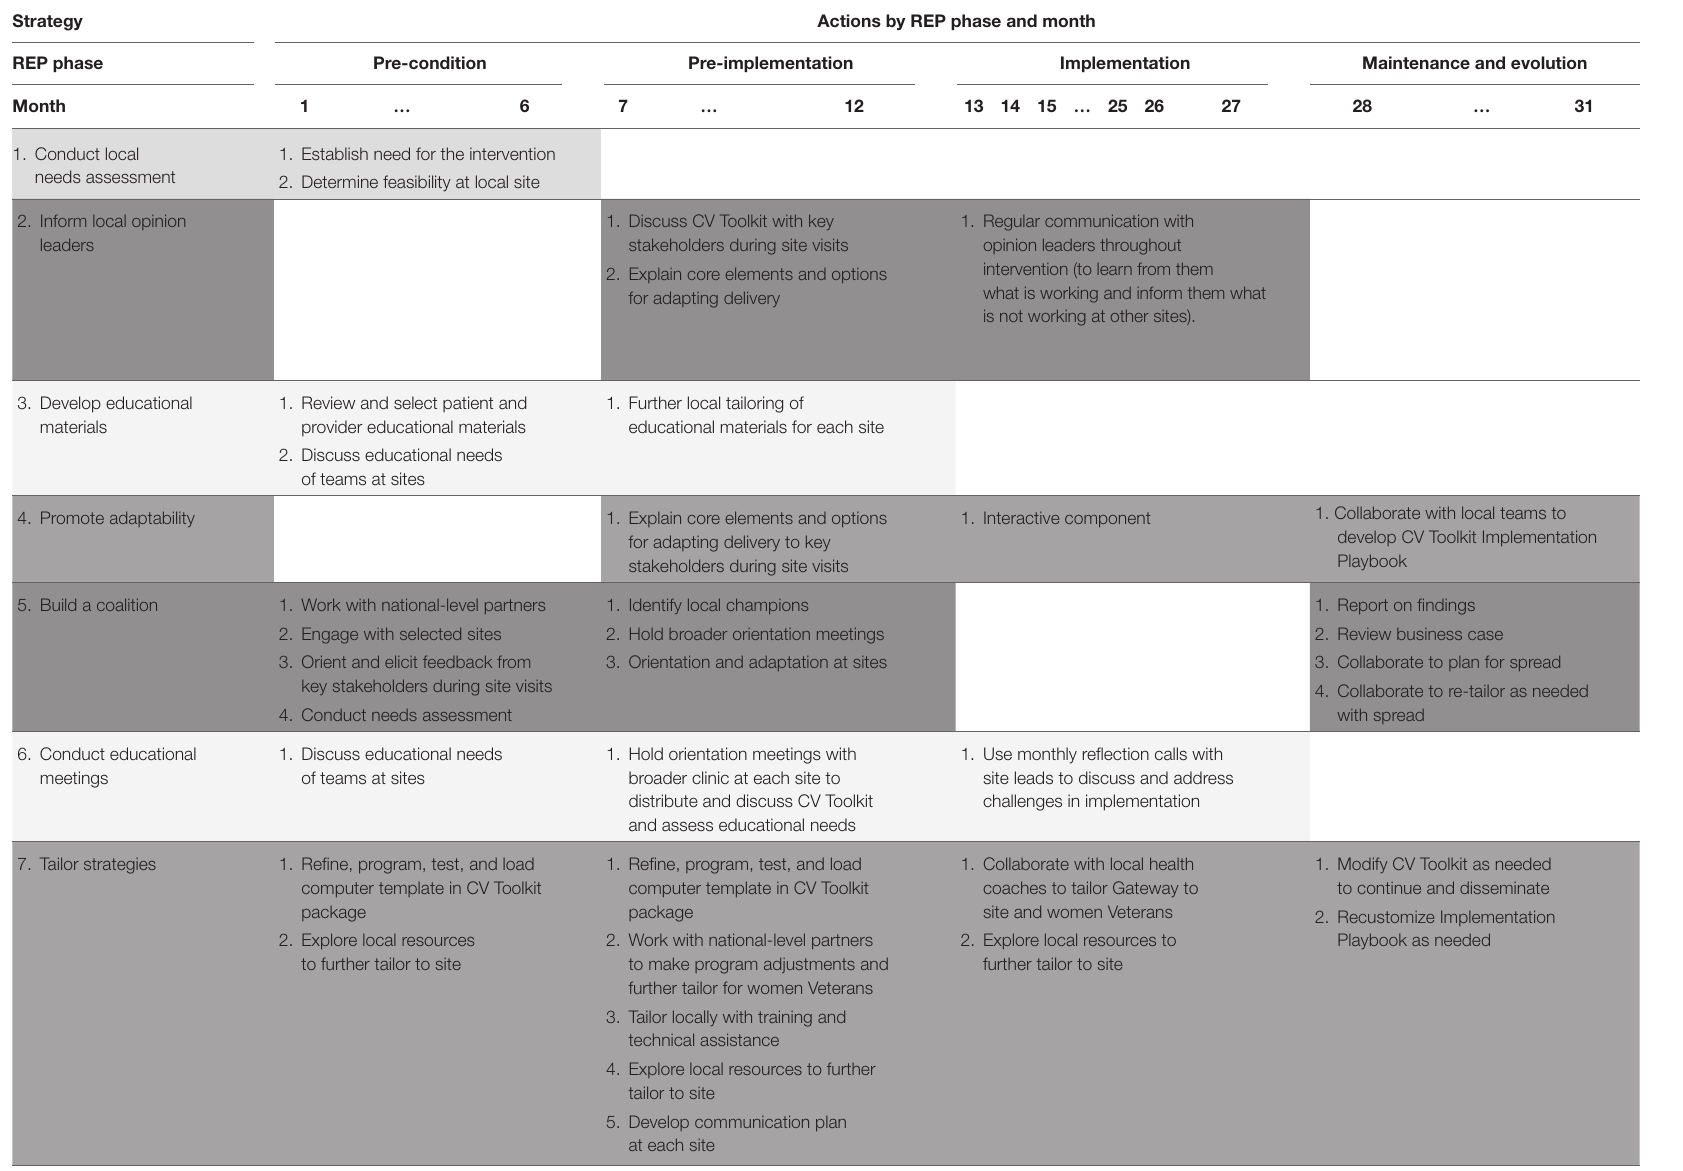
tABle 2 | Strategies facilitating actions implementing Cardiovascular (CV) Toolkit over time [by Replicating Effective Programs (REP) phase and